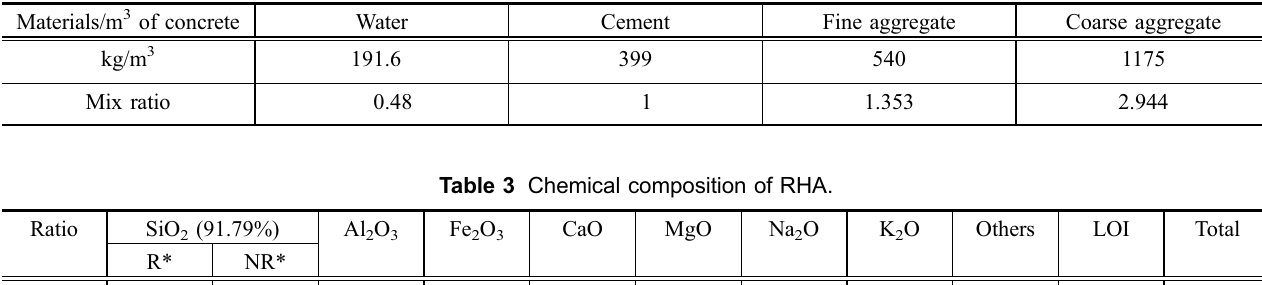
Table 2 Mix proportion for M30 concrete arrived by IS code method.